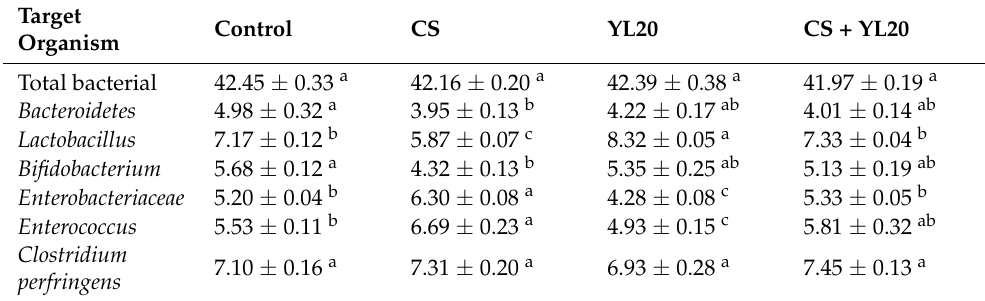
Table 5. Effect of YL20 on the abundance of dominant groups of bacteria (Lg